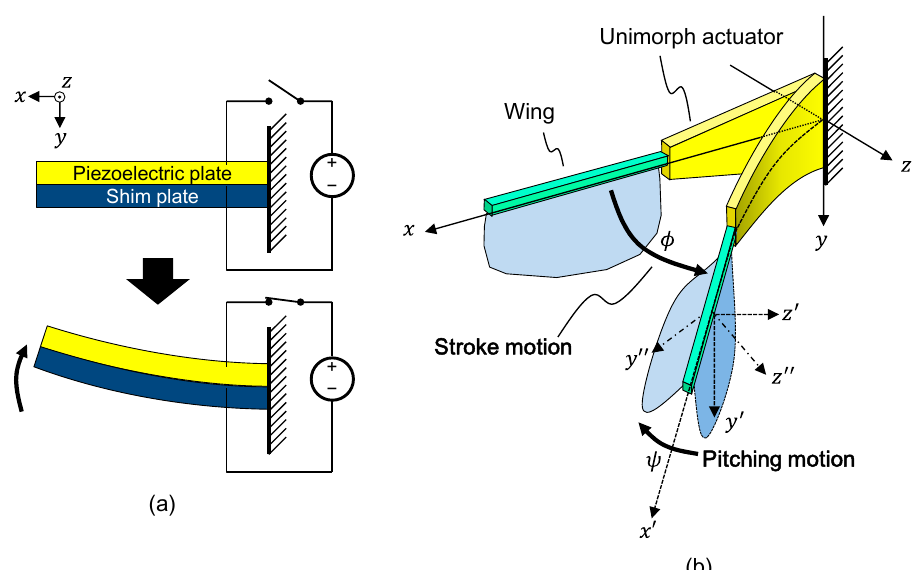
Figure 1. Behavior and structure of flapping-wing actuator with direct-driven mechanism: ( a ) actuation principle of piezoelectric unimorph actuator and ( b ) flapping motion of actuation system.